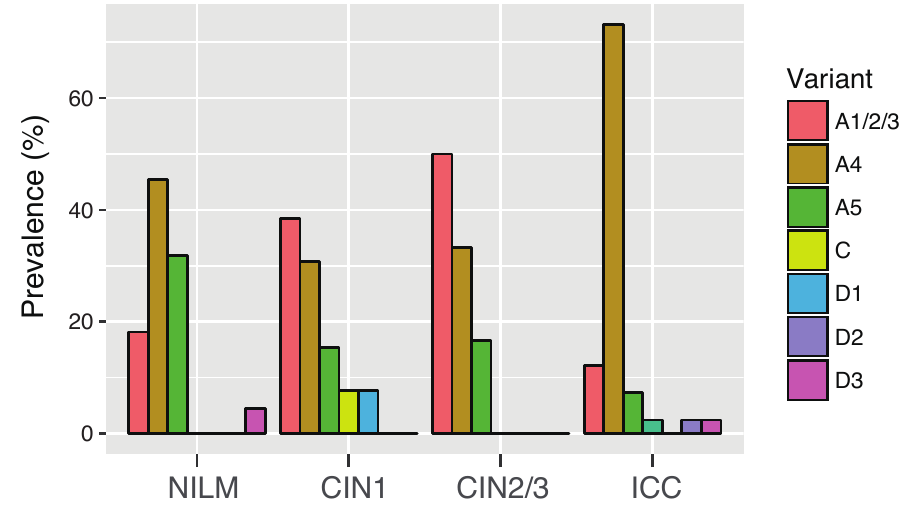
Figure 2. Distribution of HPV16 variant (sub) lineages across the histological grades of cervical lesions. The prevalence of each (sub) lineage is shown as the percentage in the total number of cases in each category. The number of samples in each category: NILM, n = 22; CIN1, n = 13; CIN2 / 3, n = 24; ICC, n = 41.